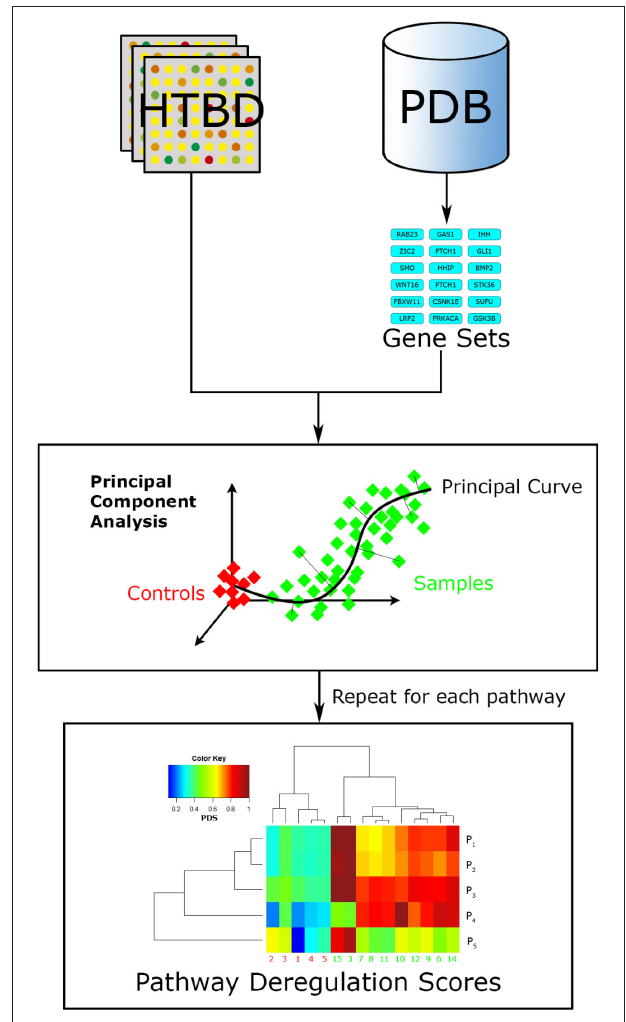
FIGURE 5 | Pathifier workflow. Pathifier needs two inputs, a list of pathways in the gene set format, and HTBD labeled for two groups (controls